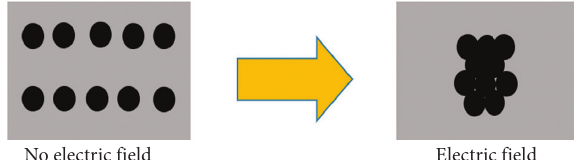
Figure 11: Internal variation of magnetic fluid in an applied electric